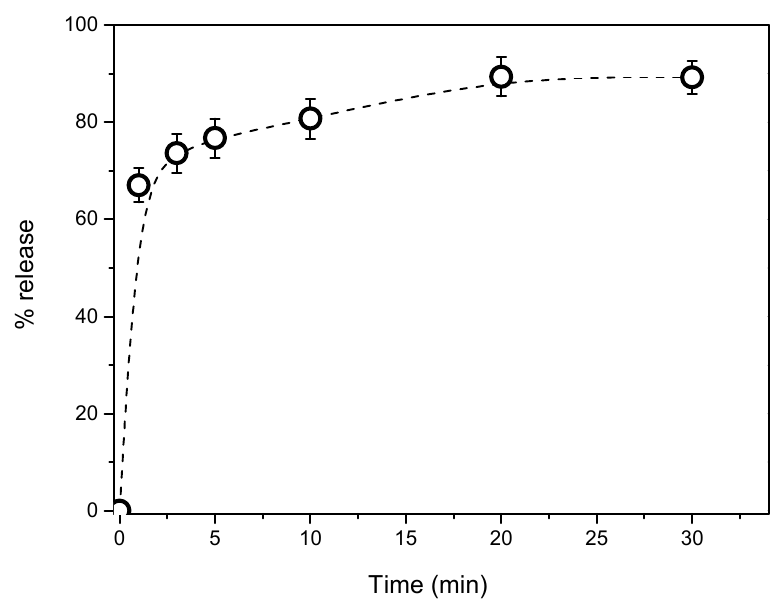
Figure 6. Release kinetics curve of doxorubicin from DOX-MWCNTs. Data are presented as mean ± SD ( n = 3).